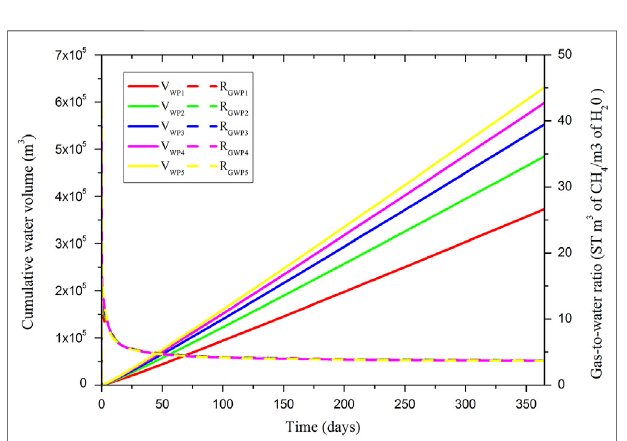
FIGURE 11 | Time-varying curve of cumulative water production ( V WD ) and gas – water ratio ( R GWD ) in case of different fracture permeabilities.